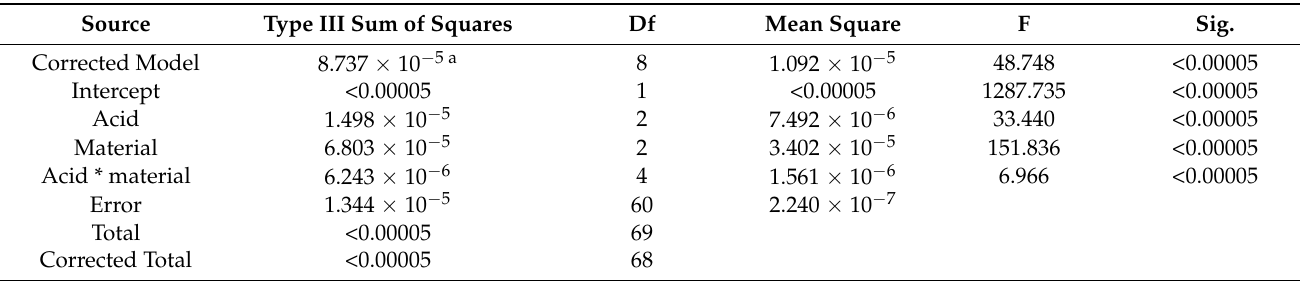
Table 2. Analysis of variance showed a difference in wear in relation to the material, acid load, and the combination of material and acid load (acid *